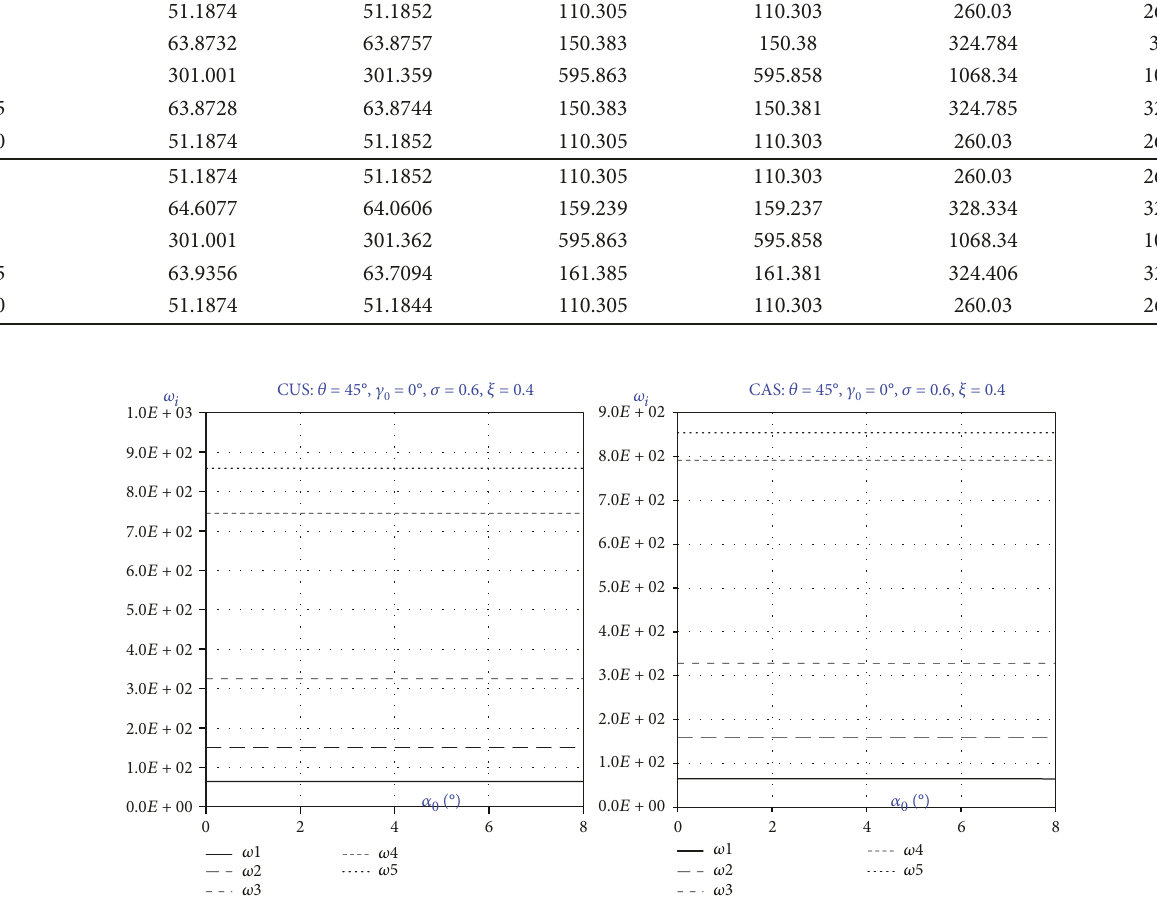
= 0 for CUS and CAS. 0